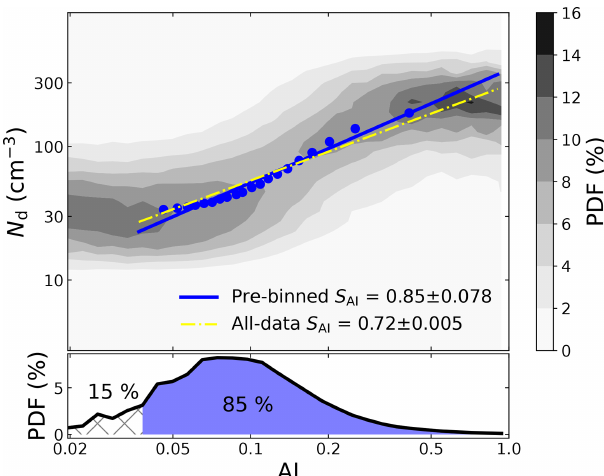
Figure 1. Schematic diagram of the procedure for calculating the sensitivity (linear regression coefficient in log–log space) of N d to CCN; AI is taken as a example. The upper panel shows the global joint N d –AI histogram, wherein each column is normalized so that it sums to 1. The blue line is a linear regression on the 20 paired N d –AI (blue dots) that are the medians of each AI bin with an equal number of samples, and the yellow dashed line shows a linear re- gression on all data points. Note that the lowest 15% of AI values have been left out according to occurrence (bottom) before binning the data. The cloud susceptibilities to AI ( S AI ) derived from both approaches are shown along with 95% uncertainty estimates (ac- cording to a Student’s t test). The data used here are the same as in Sect.